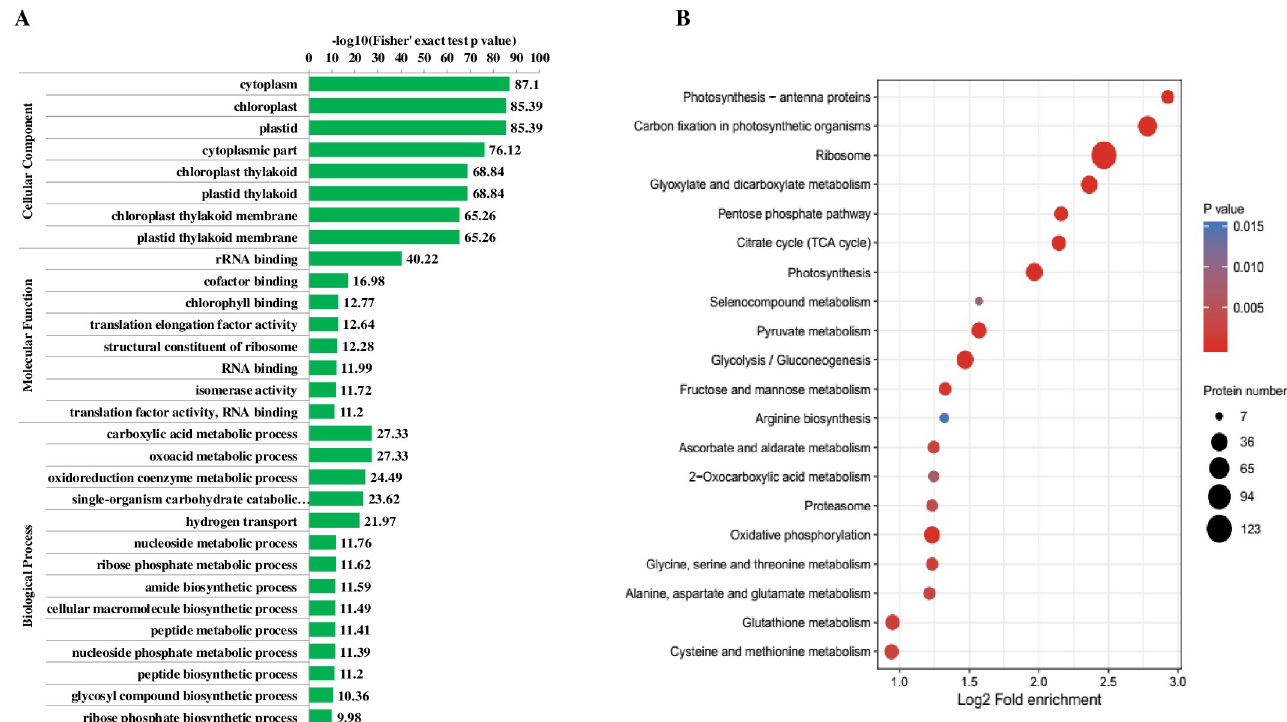
Fig 5. Enrichment analyses of all the Khib proteins. (A) Enrichment analysis based on GO annotation. (B) Enrichment analysis based on KEGG pathway.